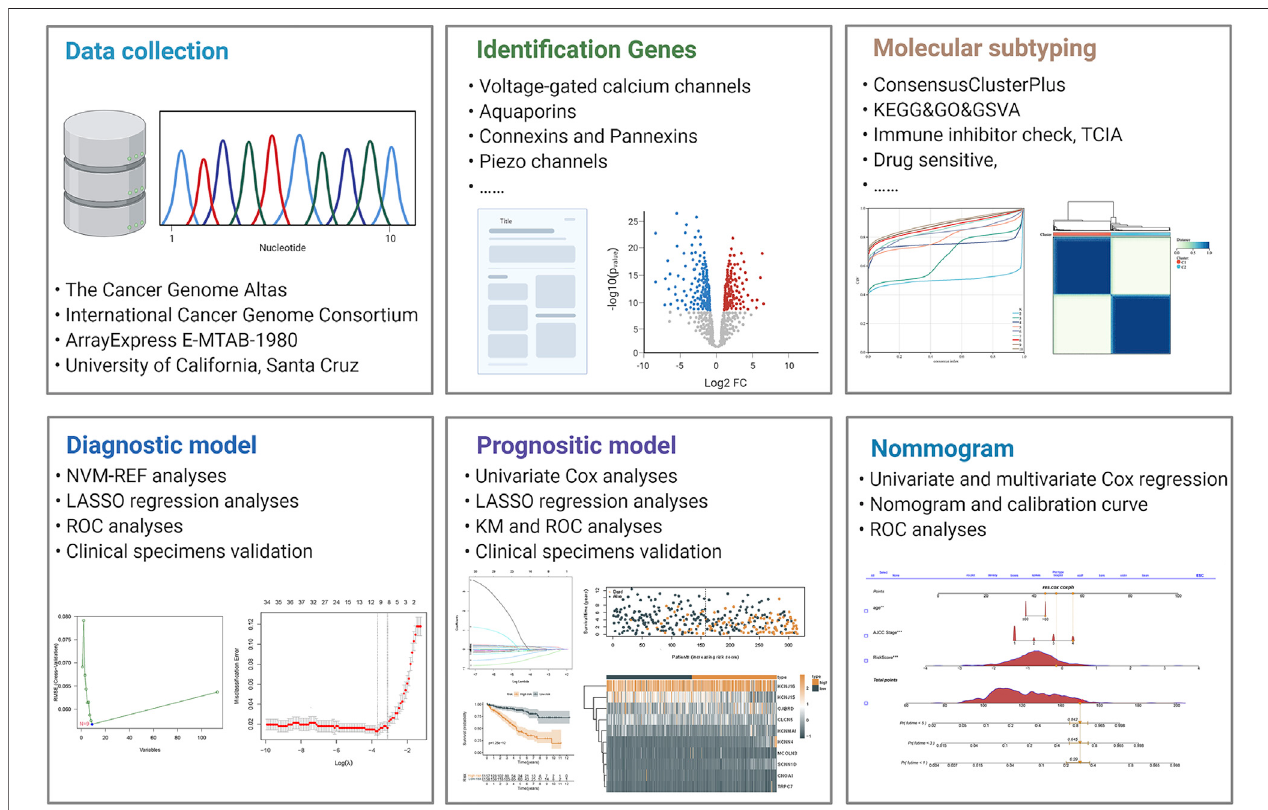
FIGURE 1 | Graphical outline diagram of the entire process of this